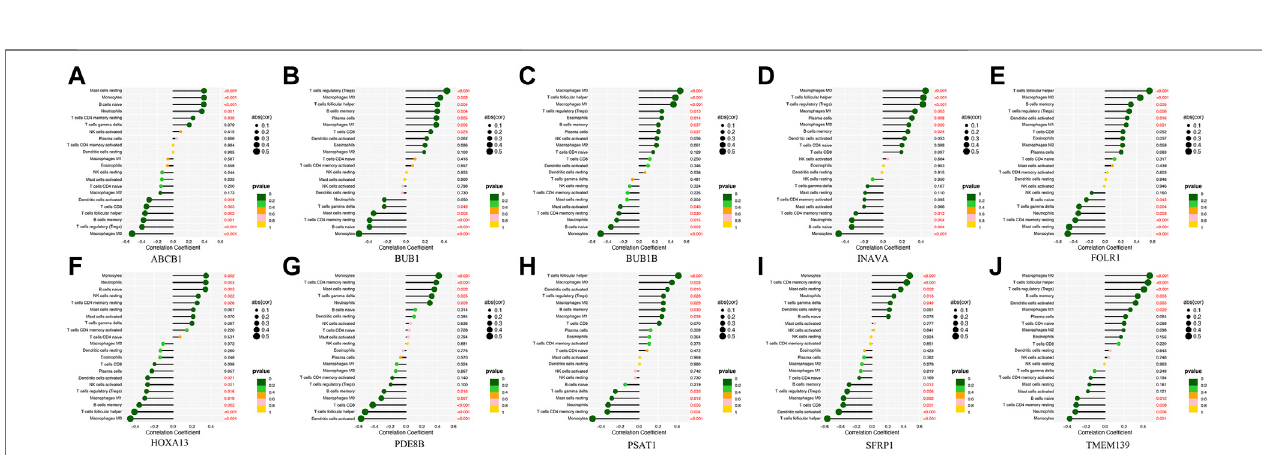
FIGURE8| Thecorrelationlollipopplotshowstheresultsofimmunecellandtargetgenecorrelations. (A-J) Associationbetweenthediagnostic-relatedgenesand immunecellin fi ltration.Thehorizontalcoordinateindicatesthecorrelationcoef fi cient,andtheverticalcoordinateindicatestheimmunecellname.Thecirclesizeindicates the absolute value of the correlation coef fi cient, the color indicates the p -value of the correlation test, and the p -value size is indicated by color.